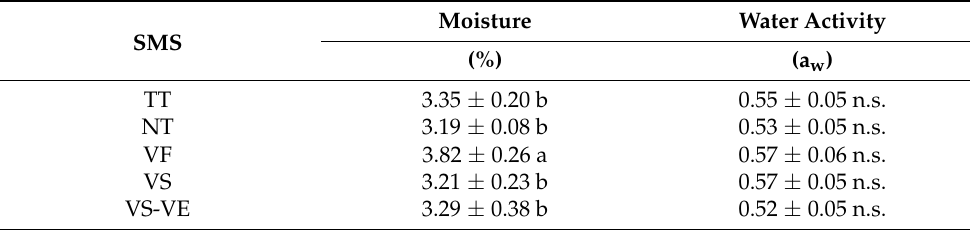
Table 6. Average moisture content and water activity in almonds from each soil management strategy. SMS